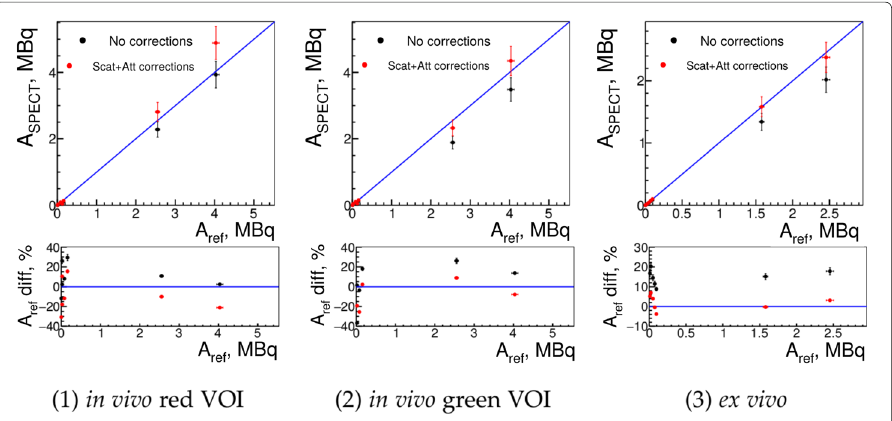
Fig. 9 Activity from SPECT images in in vivo and in ex vivo studies (tumors). The image-based activity measurements on tumors for uncorrected images (black) and after attenuation correction (red). From left to right: (1) on in vivo in the red VOI of Fig. 2; (2) on in vivo in the green VOI of Figure 2; (3) on ex